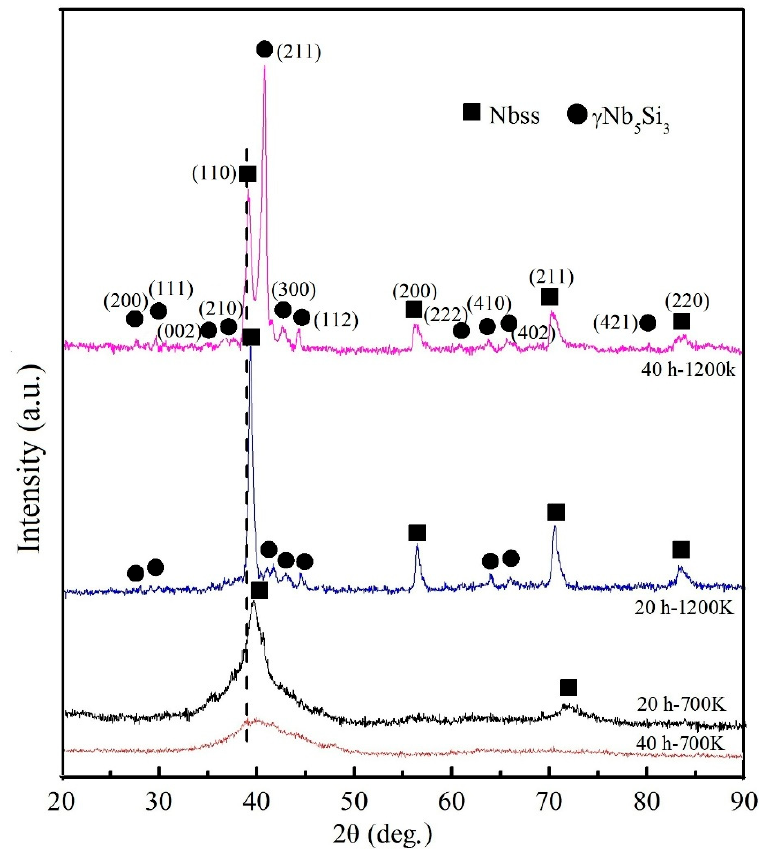
Figure 9. XRD patterns of the quenching samples at 700 K and 1200 K during the DSC process for the powders after ball milling for 20 and 40 h.